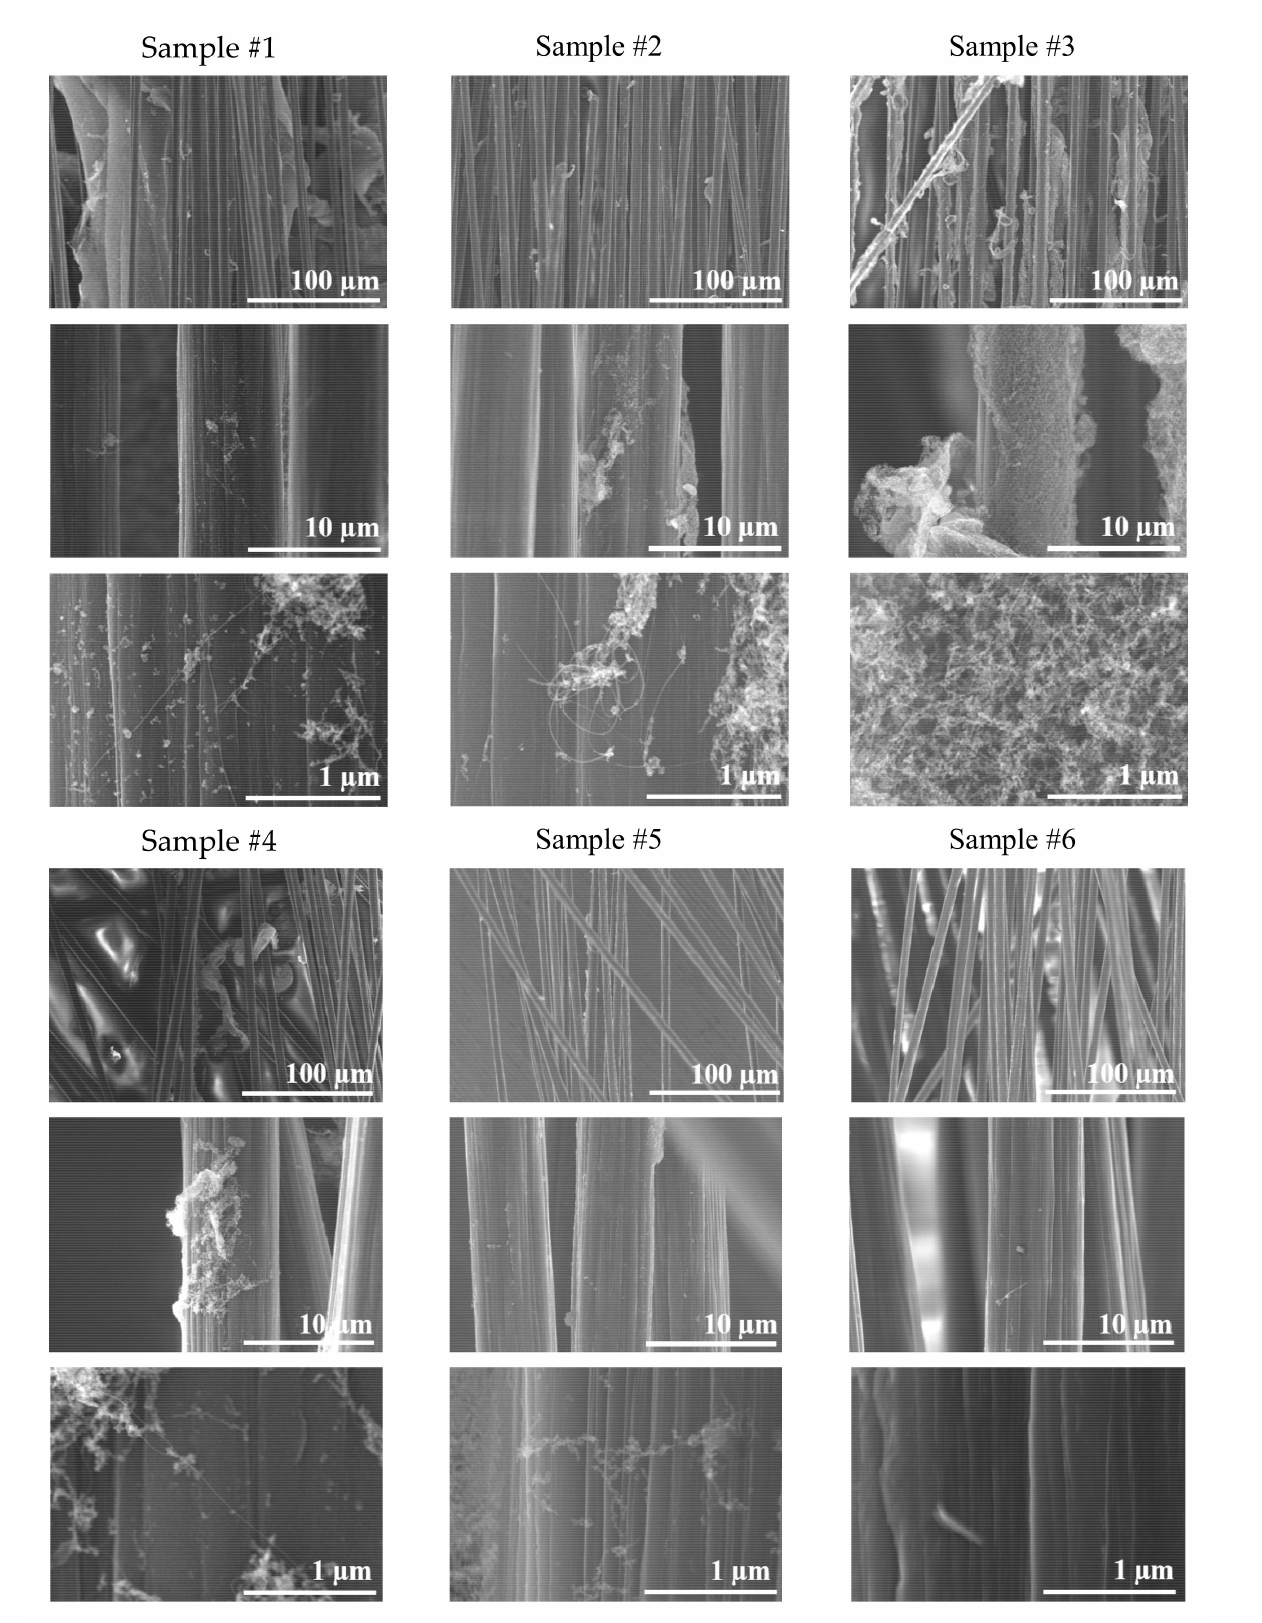
Figure 11. SEM micrographs of desized carbon fibres at various temperatures, PLD exposures, several